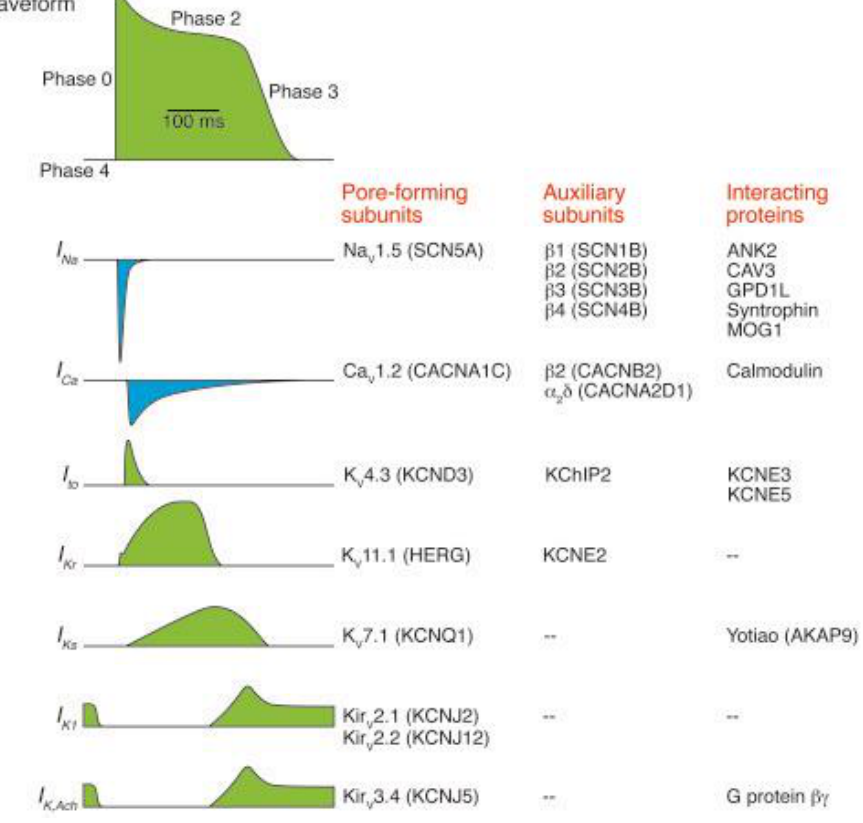
Figure 2. Ionic and molecular basis of cardiac action potential. Left: the ventricular action potential waveform with different phases and representative of inward (blue) or outward (green) currents. Right: molecular components of each ionic current, separated in channel-forming subunits, auxiliary subunits and interacting proteins (adapted from: George A.L. Jr. [5]).